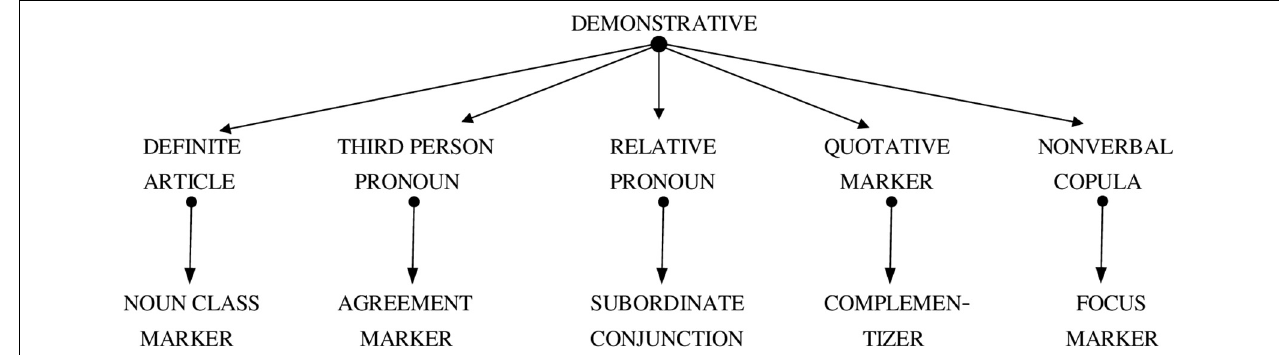
available for each child. All 20 children were younger than 25 months and their data include a minimum of 3400 words per child. The results of this study are summarized in Supplementary Datasheet 2 of the Supplementary Materials